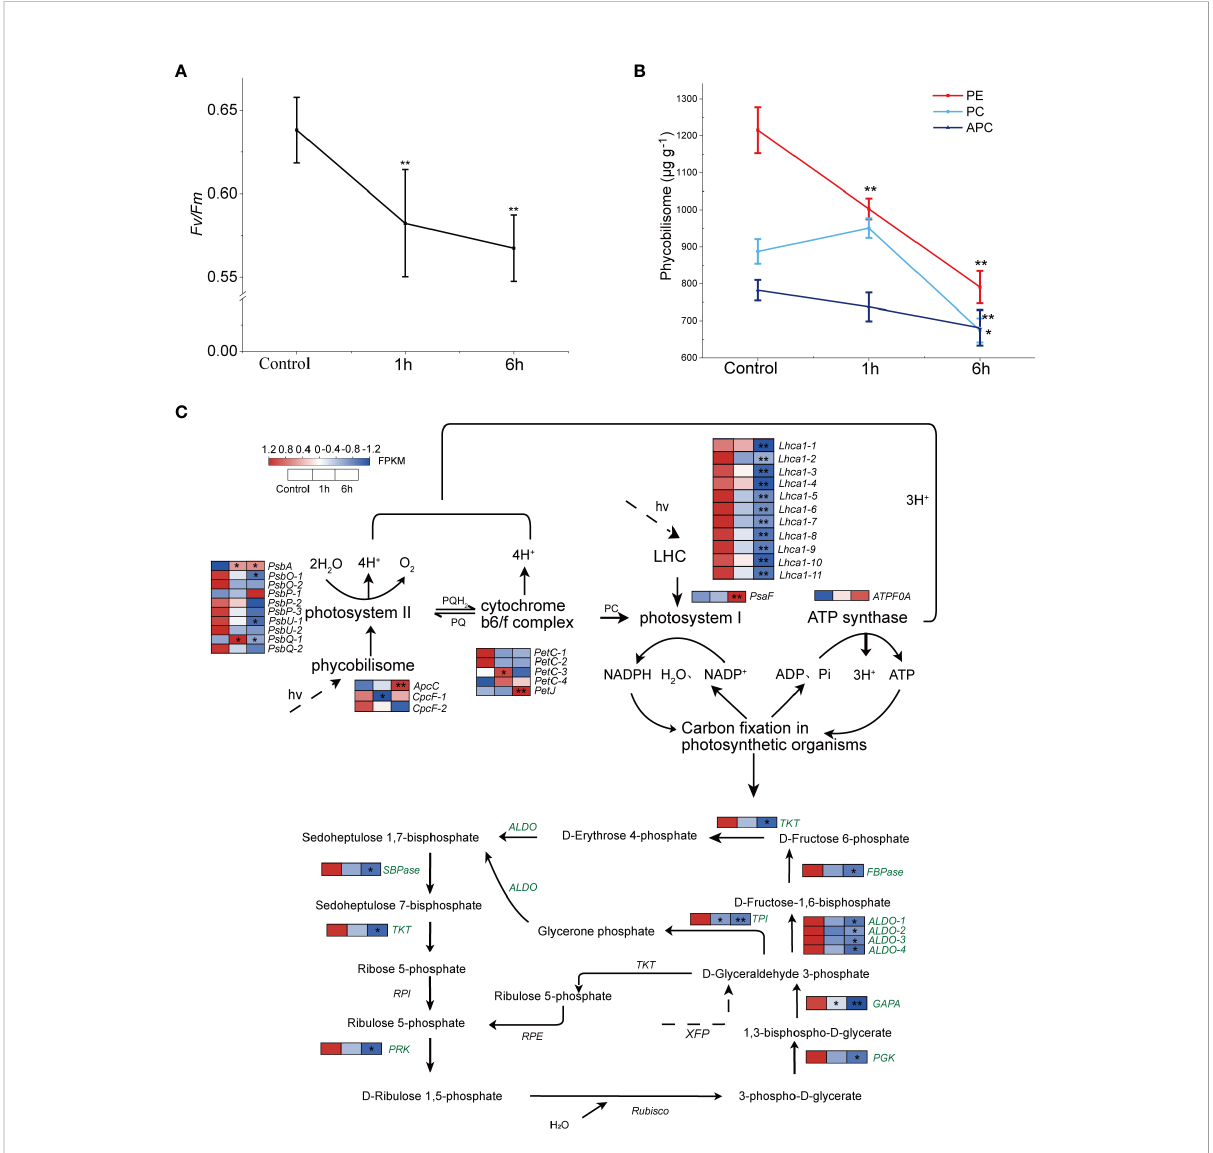
FIGURE 3 Effects of exogenous abscisic acid (ABA) on photosynthesis in Neoporphyra haitanensis. The thalli were treated with 100 m M of ABA for 1 or 6 hours. (A) Effects of ABA treatment on the photochemical ef fi ciency ( Fv/Fm ) of thalli. (B) Changes to the content of three phycobiliprotein in response to ABA. (C) Transcriptome expression pro fi les of the N. haitanensis photosynthetic system and Calvin cycle following ABA treatment. Data for the Control group, the 100 m M ABA treatment groups (both 1 and 6 hours) (from left to right) is shown near the pathway as heatmaps. The heatmaps show gene expression levels (normalized FPKM) (n = 3). For every panel, * P < 0.05 and ** P < 0.01, signi fi cance was determined when comparing treatment groups to the control